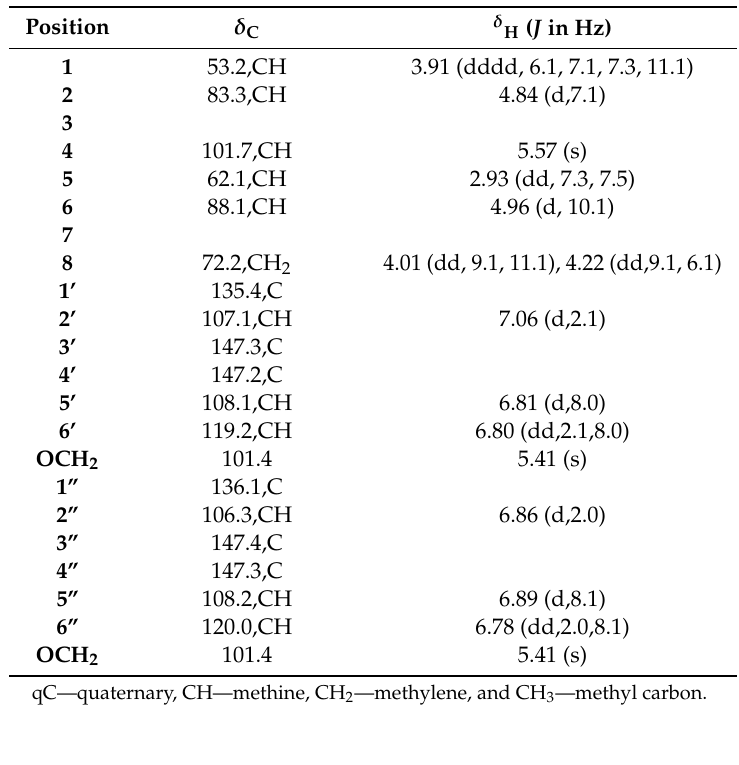
Table 2. DEPT-Q (400 MHz) and 1 H (100 MHz) NMR data of compound 35 in CDCL 3 ; Carbon multiplicities were determined by the DEPT-Q experiments.